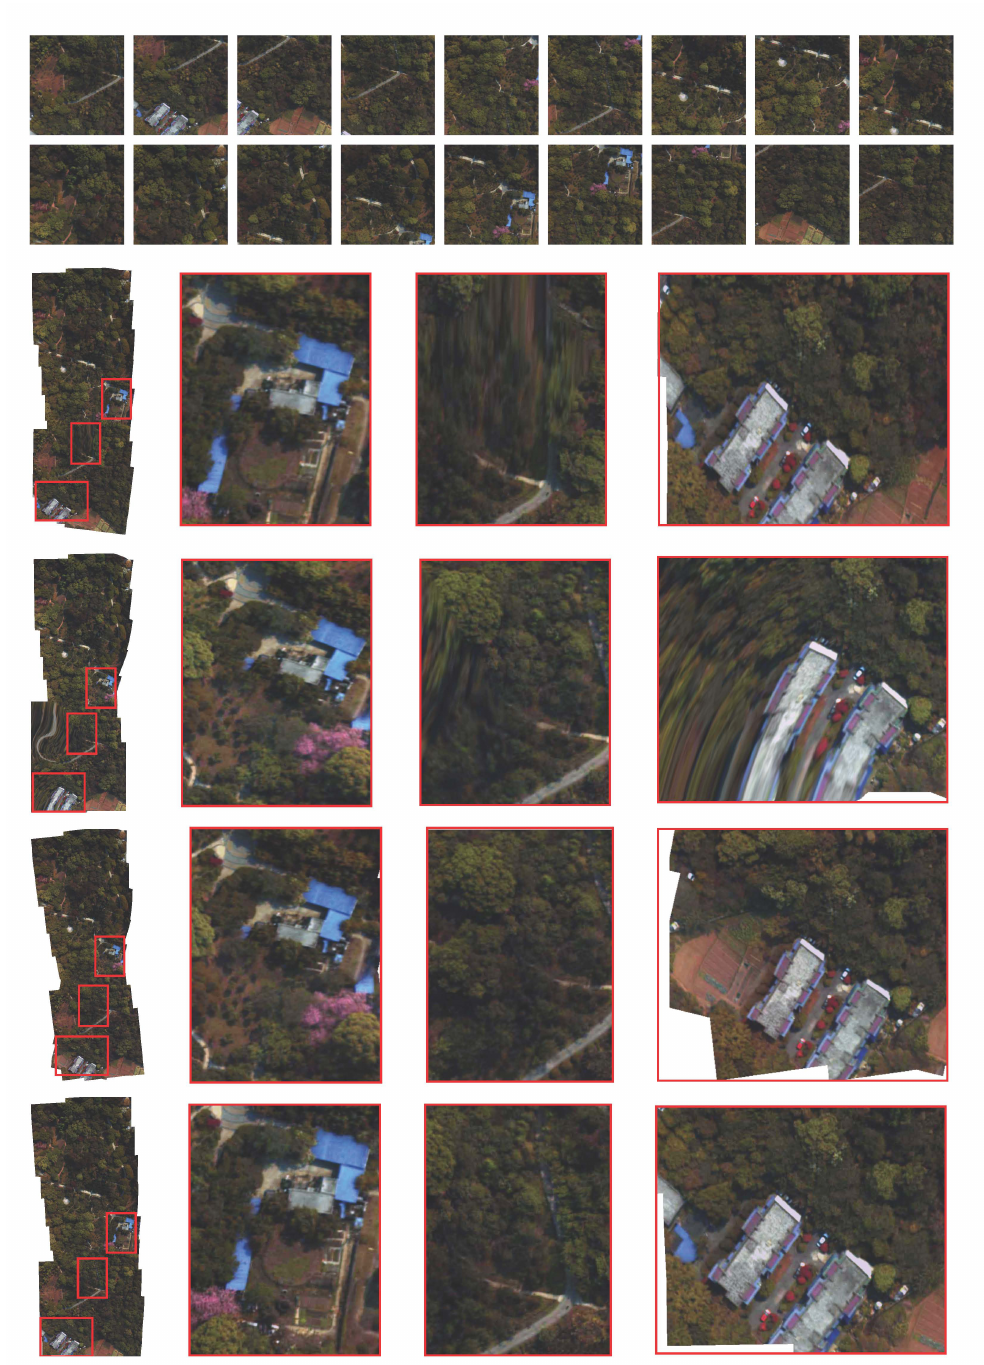
Figure 10. Comparison of the stitching results among ANAP [25], NISwGSP [26], ELA [27] and the proposed method (from ( top ) to ( bottom )). At the top are the 18 original images to be